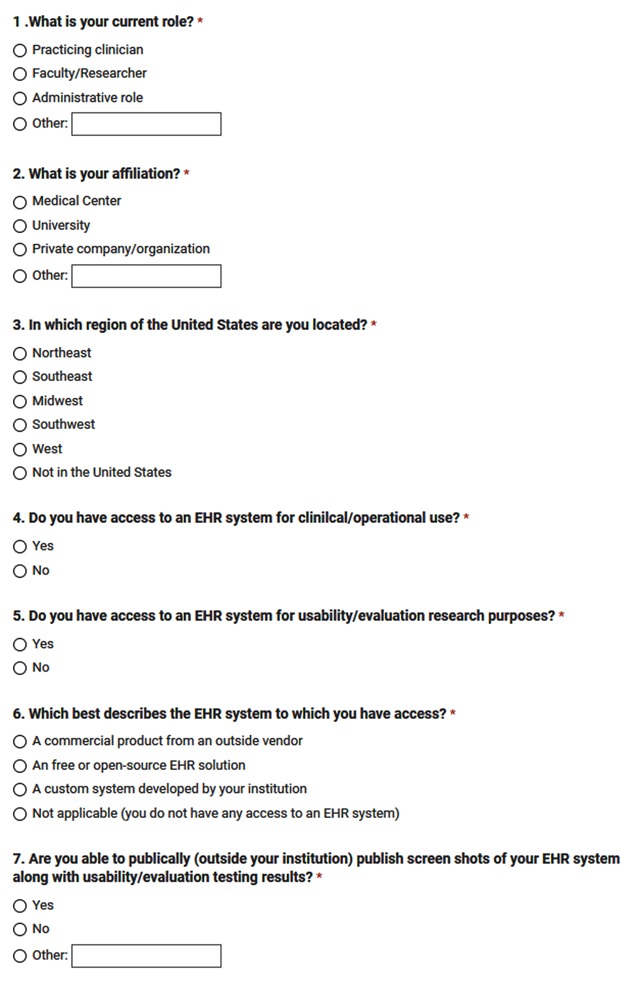
Usability Survey.